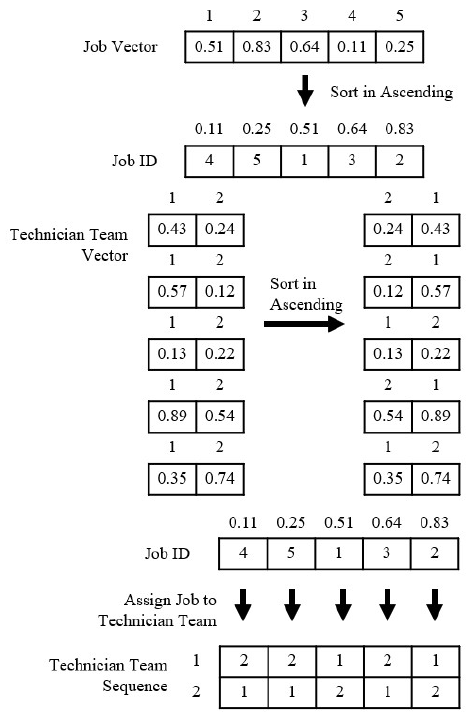
Figure 2. Illustrative example of the construction of a vector of a sub-system.